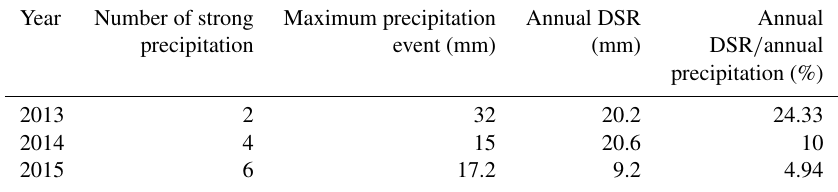
Table 3. Interannual statistics of strong precipitation and its percentage in total annual precipitation